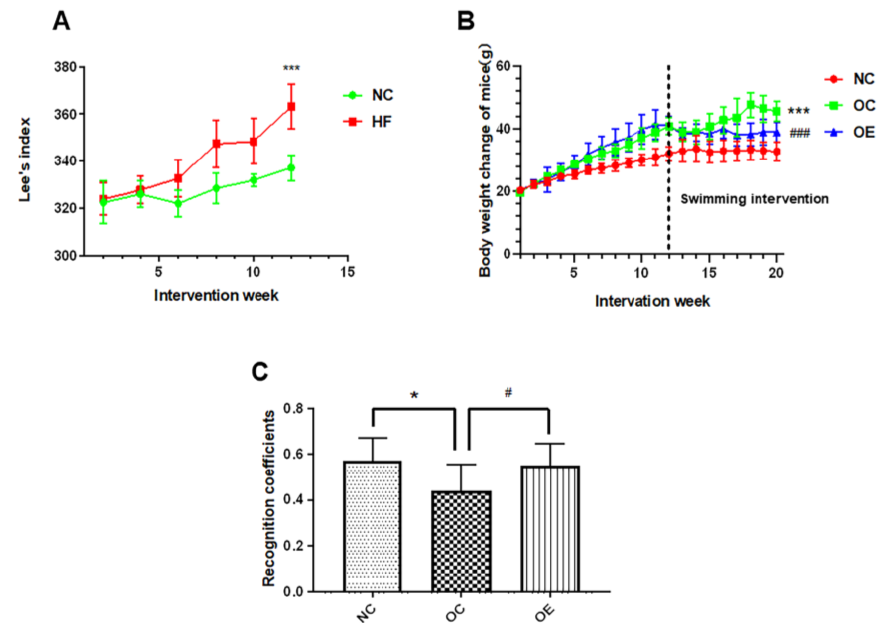
Figure 2. Effect of a swimming intervention on body weights of the mice after 12 weeks of normal chow and high-fat feeding for 8 weeks, as well as the assessment of the learning and memory capacity for the mice through a novel object recognition test. All data were presented as mean ± standard deviation (M ± SD) ( n = 7 mice per group). ( A ) statistical analysis for the changes in Lee’s index of the mice within the 12-week feeding for establishment of the obesity model; ( B ) statistical analysis of the changes in body weights of the mice in NC, OC, and OE groups upon swimming intervention; ( C ) statistical analysis of recognition coefficients of the mice from the NC, OC, and OE groups, and the recognition coefficient is equal to the times of recognizing new objects to the total times of recognizing old and new objects. Compared with the NC group, * p < 0.05, *** p < 0.001; compared with the OE group, # p < 0.05, ### p < 0.001.